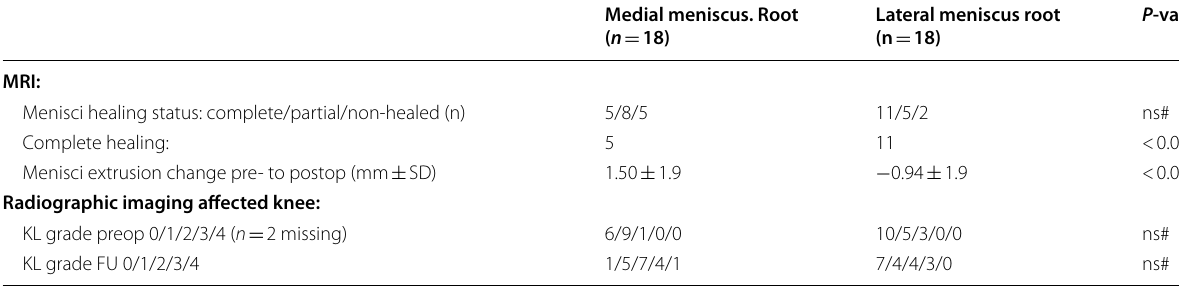
Table 2 MRI and radiographic findings of Meniscus posterior root repairs